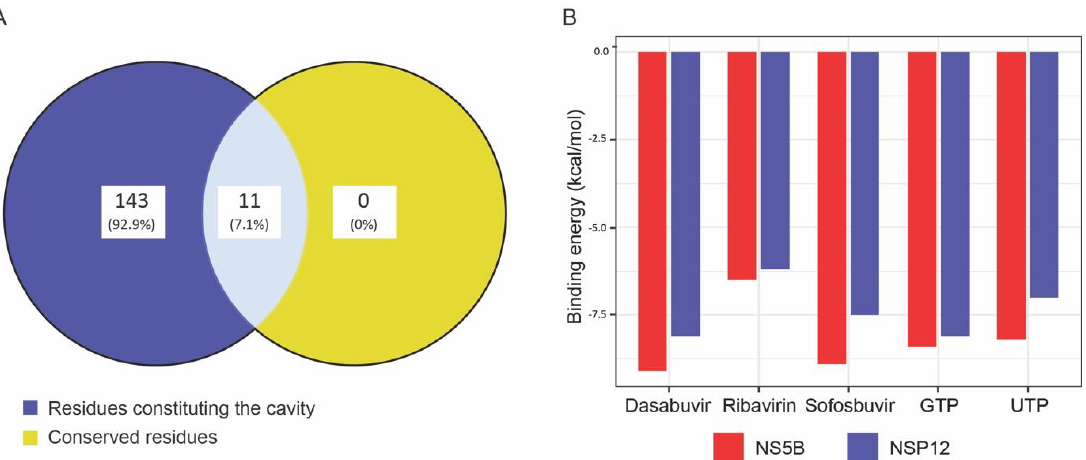
Figure 3. Comparison of conserved residues participating in ligand interactions and molecular docking score between NS5B and NSP-12. ( A ) A Venn diagram of active residues predicted from pharmacophore modeling and evolutionarily conserved residues of the RdRp domain of NSP-12. ( B ) Bar chart for comparison of binding energy score from AutoDock Vina between NSP-12 of SARS-CoV-2 and NS5B of HCV.